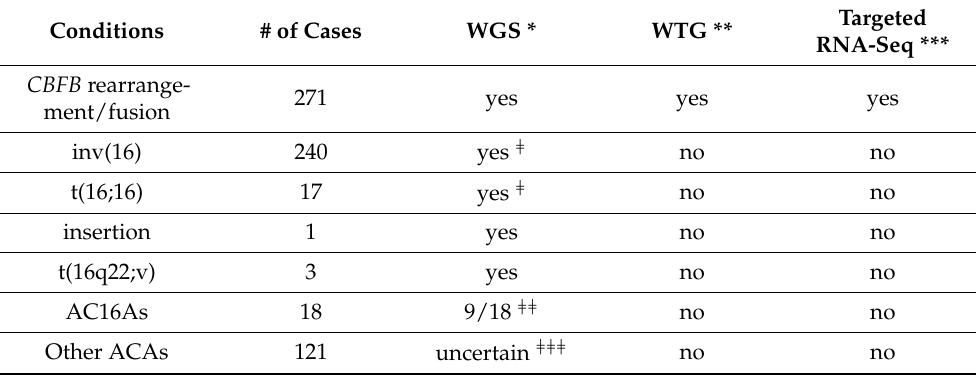
Table 5. Estimated possibilities that the NGS-based methods may detect abnormalities in this cohort of 271 cases with CBFB